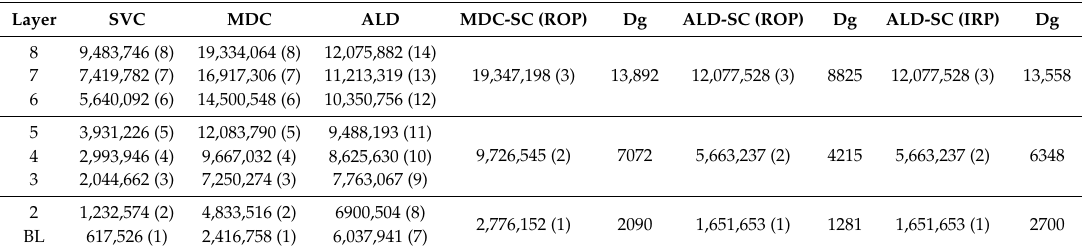
Table 9. Transmission byte cost for Different Encoding